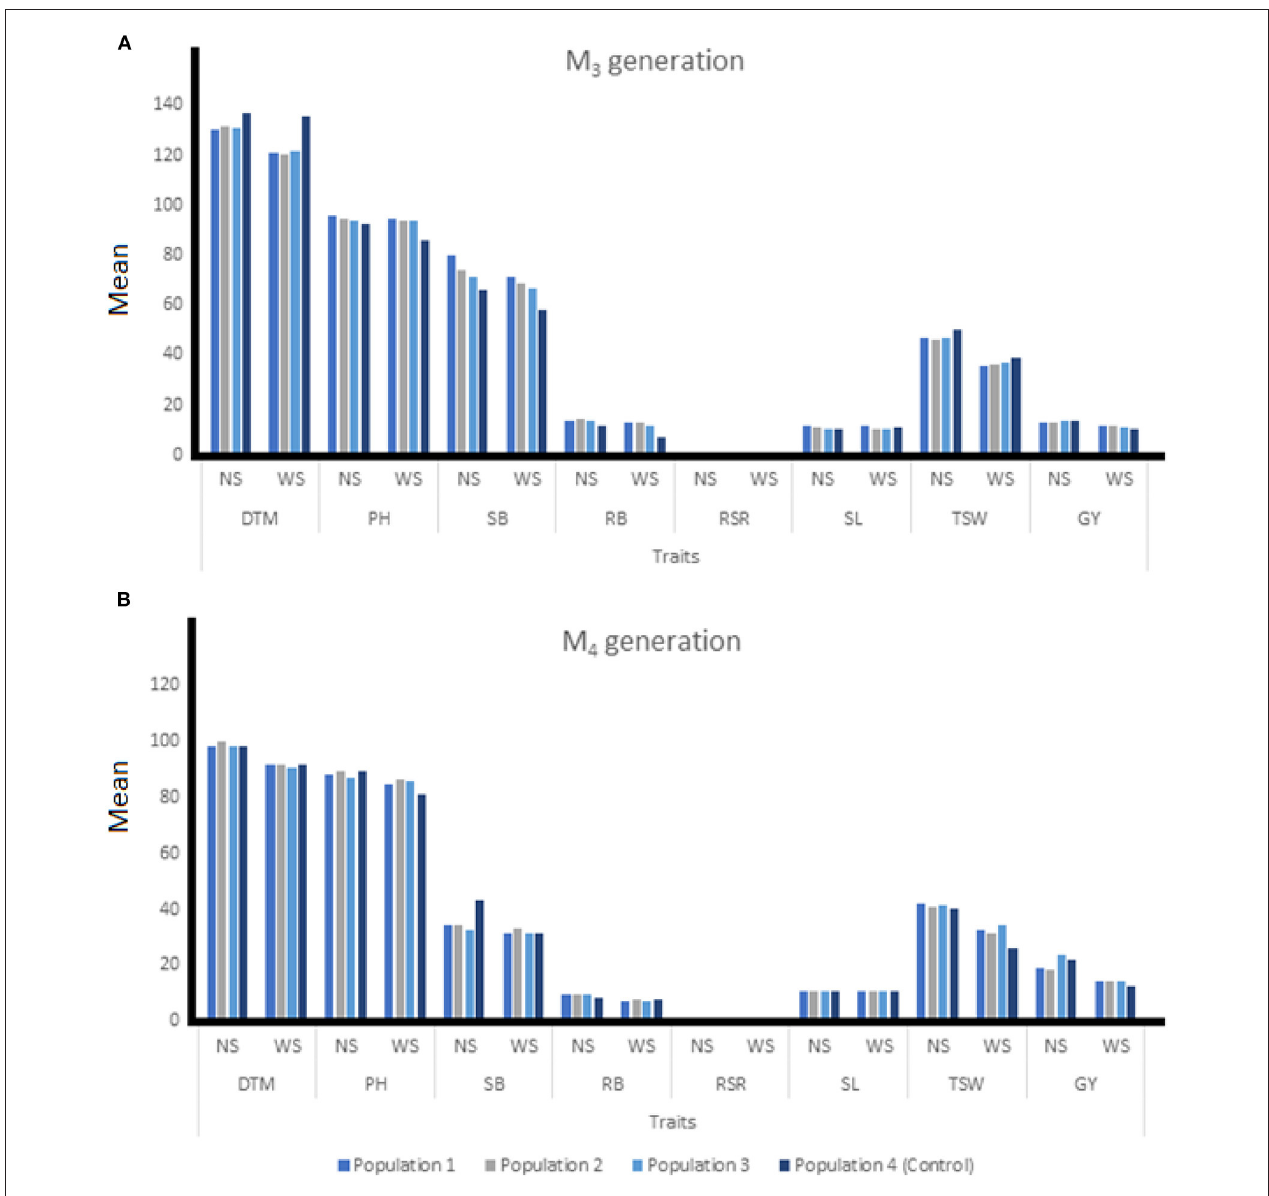
FIGURE 3 | The means of individuals among three EMS-treated and control populations of wheat at M 3 (A) and M 4 (B) generation under two water regimes. NS, non-stressed condition; WS, water stressed condition; DTM, days to 90% maturity; PH, plant height; SB, shoot biomass; RB, root biomass; RSR, root-shoot ratio; SL, spike length; TSW, 1000-seed weight; GY, grain